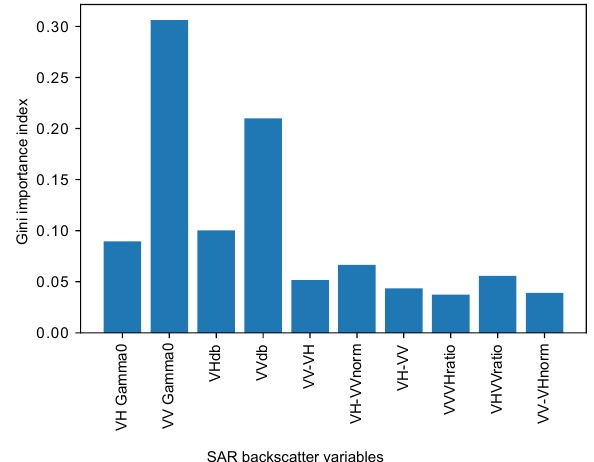
Figure 11. Barplot of SAR backscatter importance based on the Random Forest (RF) regression model prediction of canopy gap fraction from the 10 backscatter